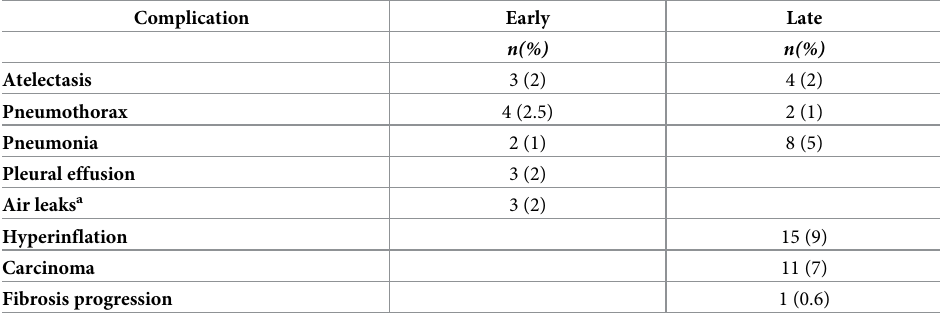
Table 1. Summary of complications in the native lung in patients after single lung